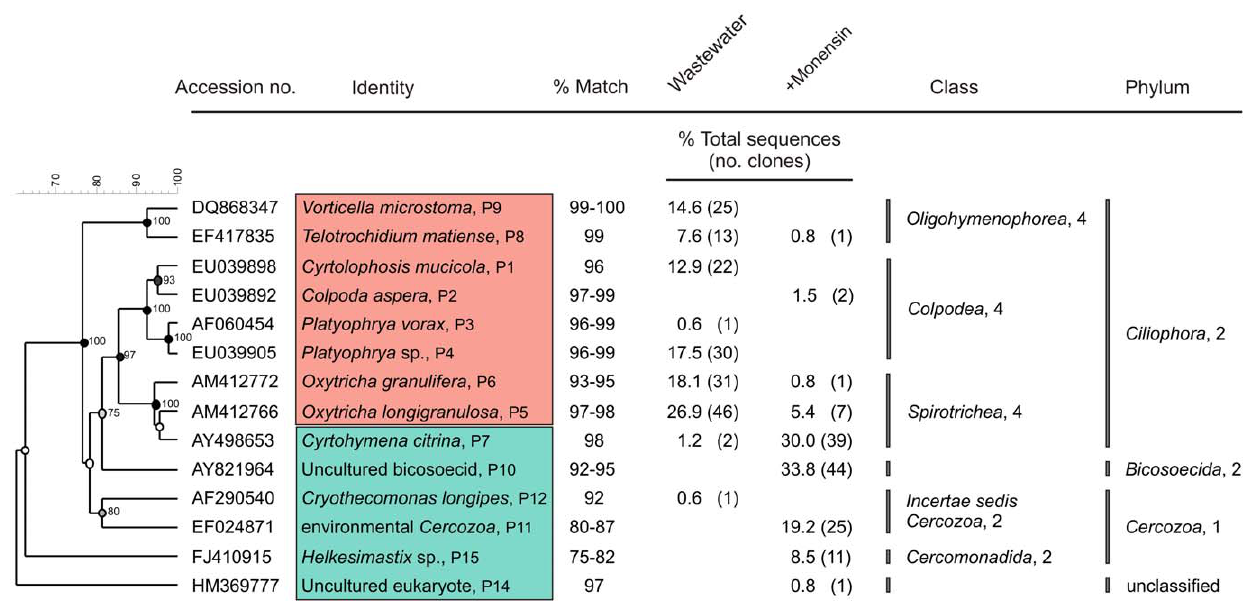
Figure 3. Protozoa characterized from dairy wastewater treated with or without monensin. Numbers P1 to P14 and P15 in the identity column correspond with DNA sequences submitted to GenBank under accession numbers HQ293258 to HQ293271 and JF423913. The number in parenthesis following the percentage of sequences is the number of clones that best matched with the GenBank sequences. Numbers following the traditional class and phylum designations are the ranks based on the new nameless ranked systematics of Adl et al. [36]. Phylum Cercozoa was elevated to first rank and the order Cercomonadida to a second rank by this classification. The identity of Helkesimastix sp. is based on only 75 to 82% match with the GenBank sequences and could be classified as an uncharacterized cercozoan. Red and green boxes respectively denote inhibition or enrichment of protozoa by monensin.